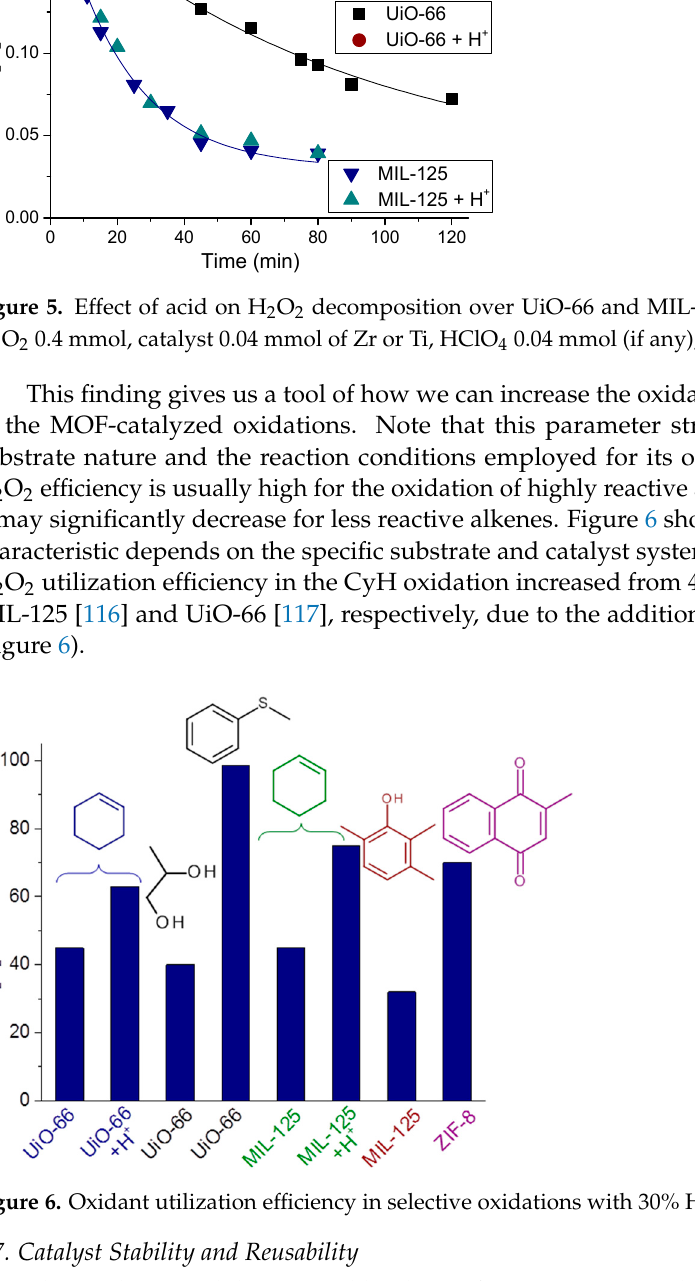
Figure 5. Effect of acid on H 2 O 2 decomposition over UiO-66 and MIL-125. Reaction conditions: H 2 O 2 0.4 mmol, catalyst 0.04 mmol of Zr or Ti, HClO 4 0.04 mmol (if any), CH 3 CN 2 mL, 50 °C.